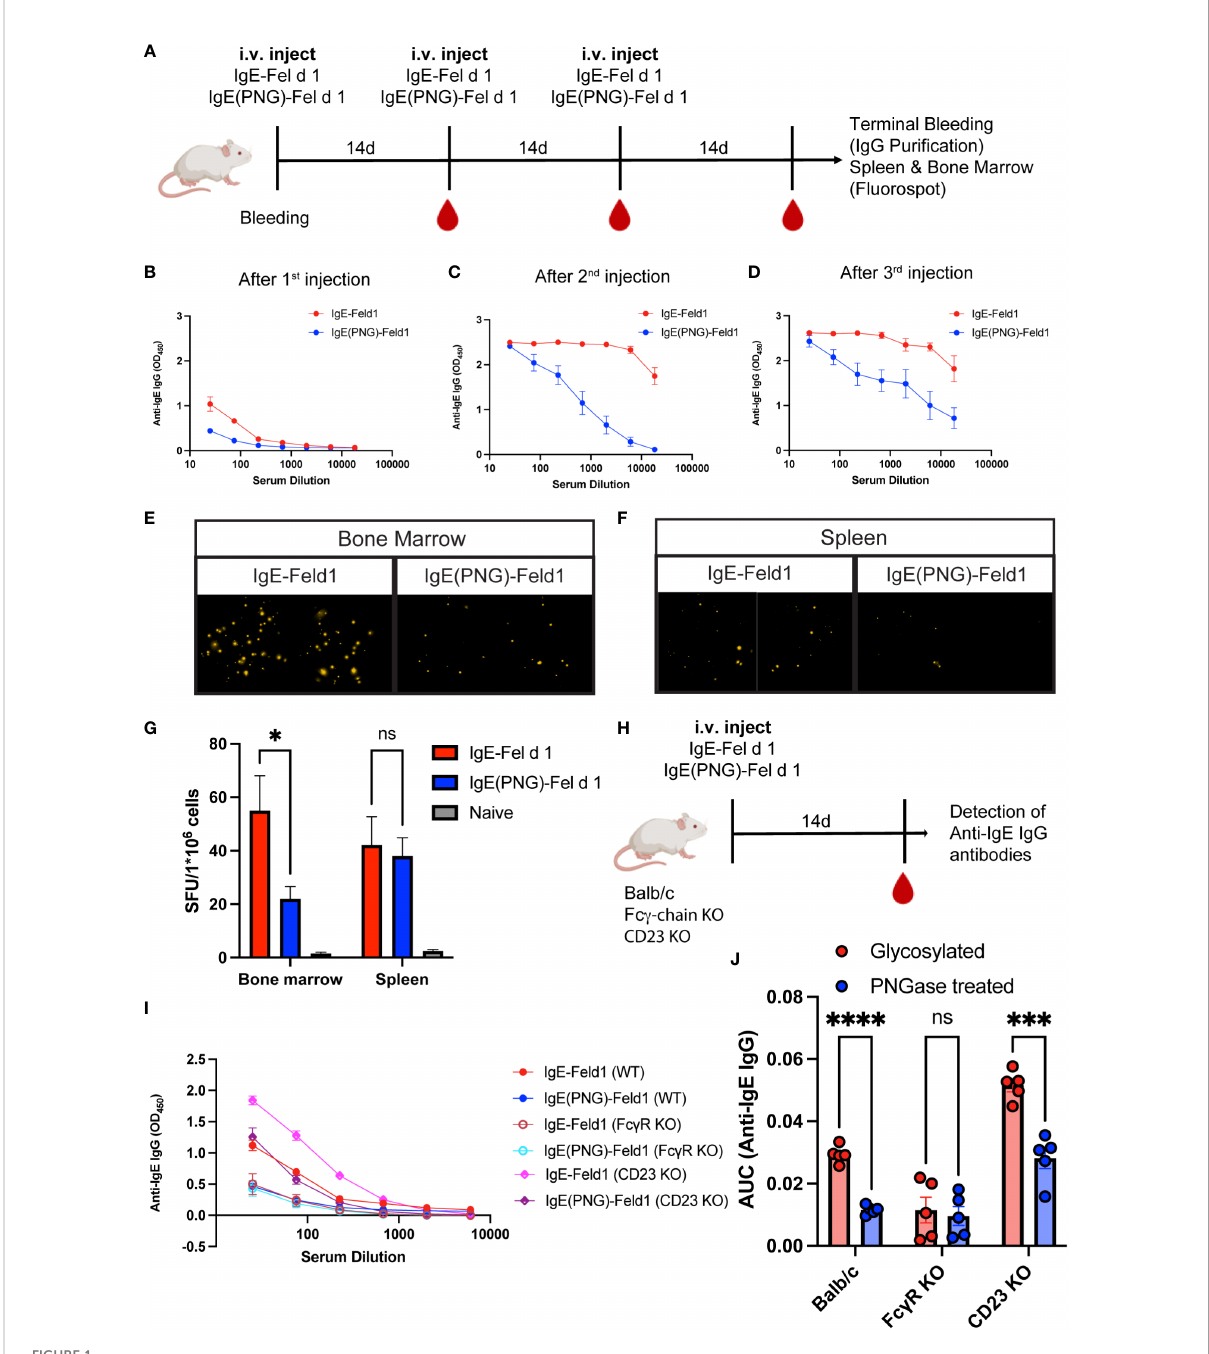
FIGURE 1 Glycosylated IgE in complex with Fel d 1 induces more IgG antibodies against IgE than deglycosylated IgE-Fel d 1 complexes. Schematic overview of the immunization regiment and timepoints of experiments (A) . Anti-IgE IgG response (at OD450 by ELISA) (B-D) 14 days after fi rst immunization with IgE-Fel d 1 or IgE(PNG)-Fel d 1 (B) , after the second immunization (C) , and after third immunization (D) . Representative images of fl uorospot experiments of anti-IgE IgG producing B cells (E, F) from Bone marrow (E) or spleen (F) . Spot forming units per 1 million cells in bone marrow and spleen (G) . Schematic overview of the immunization of Balb/c, CD23KO and Fc g -chainKO mice to compare the anti- IgE IgG response (H) . Anti-IgE IgG response at OD450 by ELISA (I) or as AUC (J) of Balb/c, CD23KO and Fc g -chainKO mice 14 days after immunization with IgE-IC or IgE(PNG)-IC. Statistical analysis (mean ± SEM) using unpaired students t-test (G) , n = 6, and multiple paired t-test (J) , n=5. The signs for statistical signi fi cance are ns = not signi fi cant, p ≤ 0.05 (*), p ≤ 0.001 (***), and p ≤ 0.0001